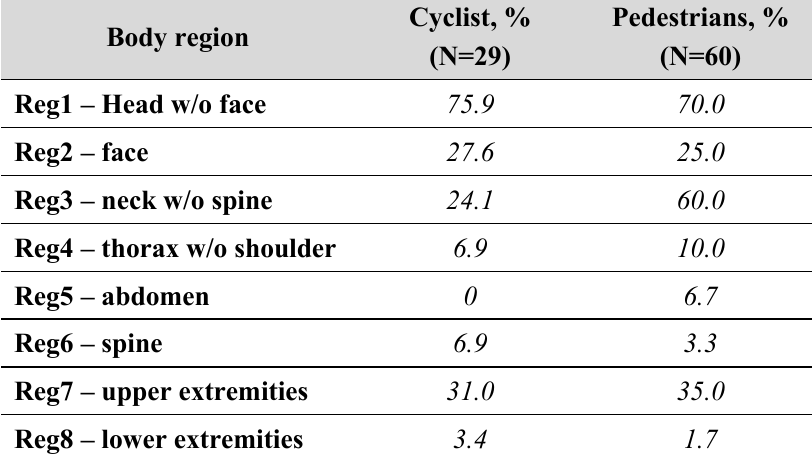
Table A8. Proportion of fatally injured cyclists and pedestrians sustaining fatal injuries from impact with the car in the listed body